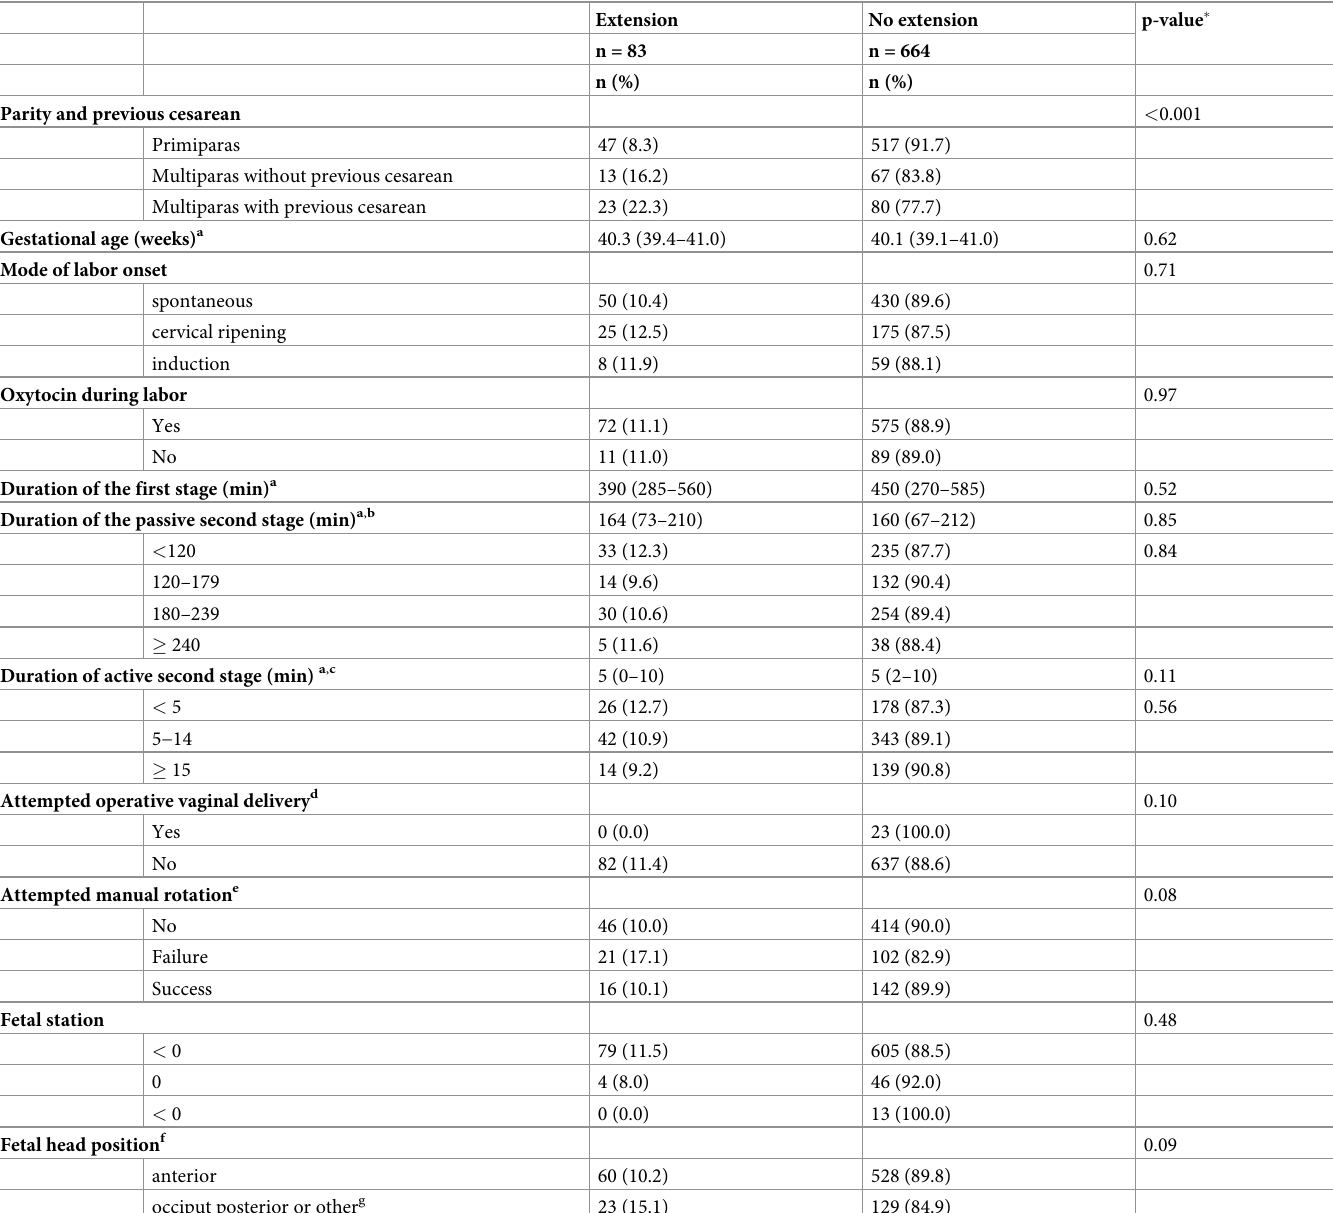
Table 2. Frequency of incision extensions according to obstetrical